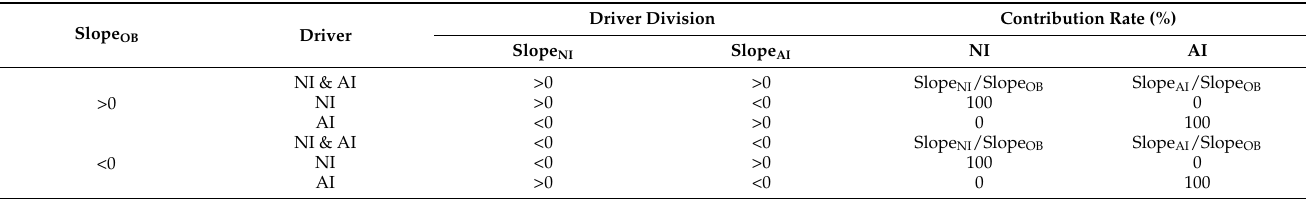
Table 2. Determination of dominant factors of anthropogenic activities and natural factors on